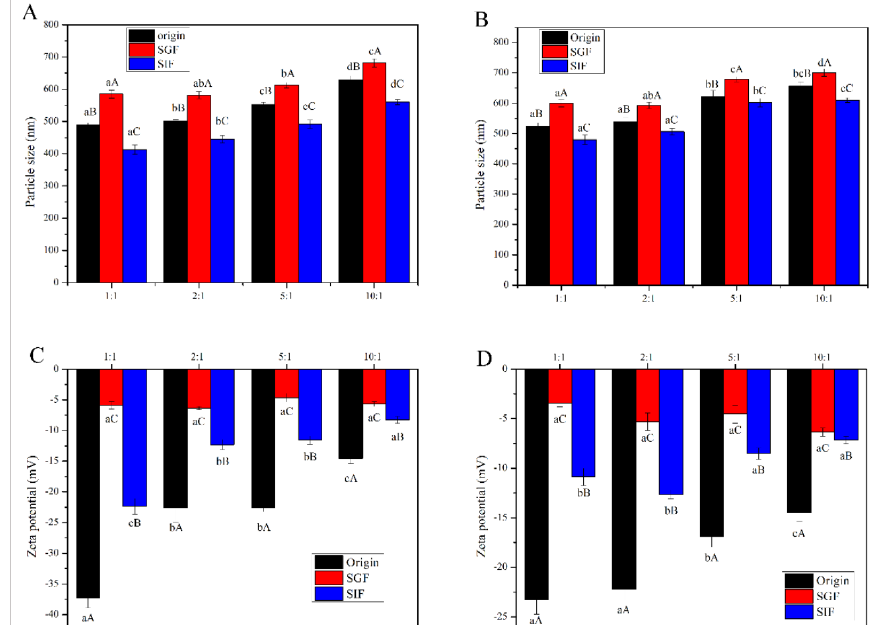
Figure 5. Particle size of ( A ) LMP-CSLG and ( B ) HMP-CSLG nanocomplexes with different CSLG concentration under simulated gastric and intestinal fluids. Zeta potential of ( C ) LMP-CSLG and ( D ) HMP-CSLG nanocomplexes with different CSLG concentration under simulated gastric and intestinal fluids. a–d Values followed by different letters in the same column are significantly different ( p < 0.05), where a is the lowest value. A–C Values followed by different letters in the Scheme 0. where A is the highest value. Low methoxyl pectin (LMP); Cationic short linear glucan (CSLG); high methoxyl pectin